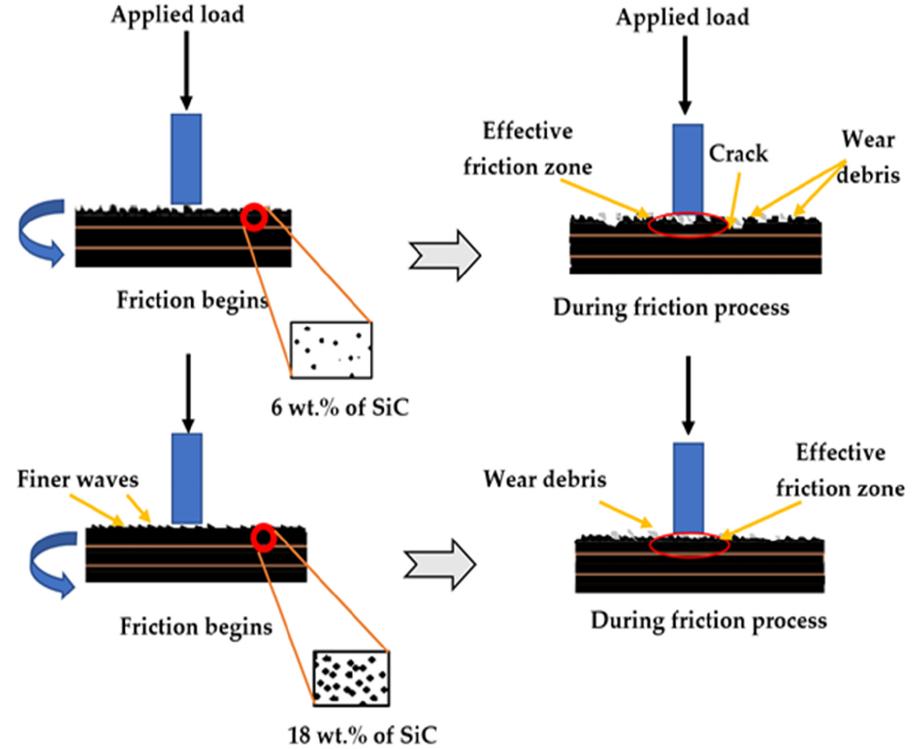
Figure 11. Schematic of expected wear steps during bin-on-disk wear test.